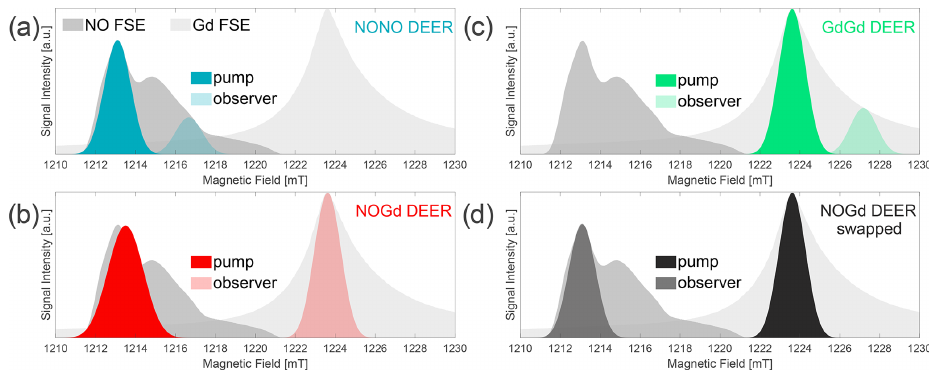
Figure 3. Three-channel DEER setups. Two field-swept echo (FSE) spectra of NO and Gd are represented as shaded gray areas, super- imposed at their relative spectral positions. Gaussian π pulse excitation profiles are shown at the respective pump and observer positions, simulated with EasySpin 5.2.2 (Stoll and Schweiger, 2006) and using the provided functions of “pulse” and “exciteprofile”. The excitation profiles represent ideal Gaussian π pulses without taking into account the spectral shape, the nonlinearity of the signal response, the res- onator profile, or the Q factor. Therefore, they are only indicative of the excitation bandwidth of the pulses. Nevertheless, we found that the correct choice of the pulse lengths and a positioning of the pump and observer frequencies in such a way that the two simulated excitation profiles do not overlap allow us to experimentally minimize the “2 + 1” signal at the end of DEER traces (Teucher and Bordignon, 2018). In setups (a–c) , Gaussian observer pulses of 32ns time base length (13.6ns FWHM) for π/ 2 and π (Teucher and Bordignon, 2018) were used in combination with a shot repetition time (srt) of 1000µs. (a) NONO DEER – a 32ns Gaussian pump at the spectral maximum of NO, with observer pulses 100MHz lower in frequency and the pump/observer placed symmetrically in the resonator profile. Performed at 50K. (b) NOGd DEER – 32ns Gaussian observer pulses at the spectral maximum of Gd, with a Gaussian pump pulse of 24ns (10.2ns FWHM) placed in the center of the resonator profile (minimum possible pulse length in our setup) at 280MHz higher in frequency than the observer. Performed at 10K. (c) GdGd DEER – as in (a) , except for the pump pulse being placed on the maximum of the Gd spectrum. Performed at 10K. (d) Swapped NOGd DEER setup – the 32ns Gaussian observer pulses at the spectral maximum of NO, with a 32ns Gaussian pump pulse 291MHz lower in frequency than the observer. Performed at 30K with a srt of 10000µs. The observer was placed + 50MHz off-center in the resonator